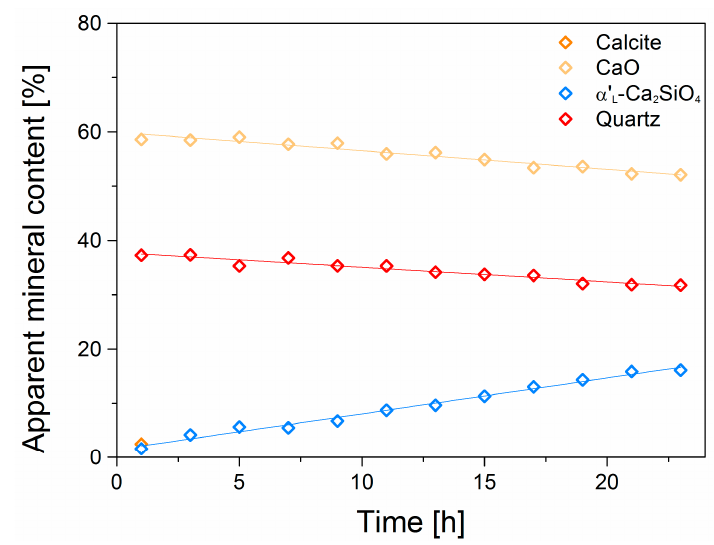
Figure 14. The evolution of the mineral fractions as a function of time during isothermal sintering of a quartz-calcite (mass ratio 1:1) green body at 848 °C obtained by the binary images of the single phases. The colored lines represent a linear fit to the data over the whole time interval.